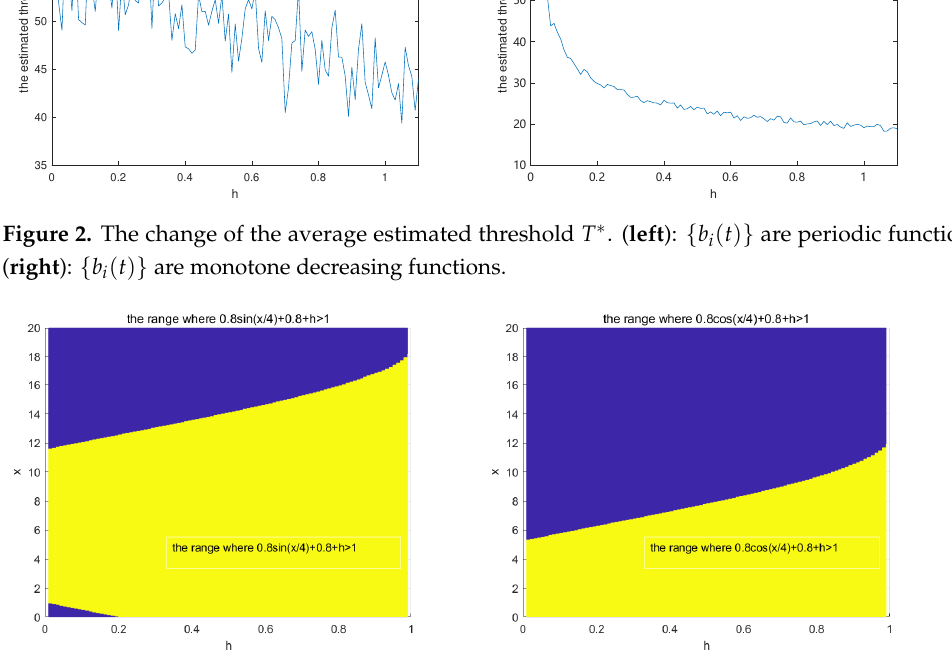
Figure 3. The first ranges where b i ( t ) > 1 change as h increases from 0 to 1. ( left ): { b i ( t ) } are sine functions; ( right ): { b i ( t ) } are cosine functions.